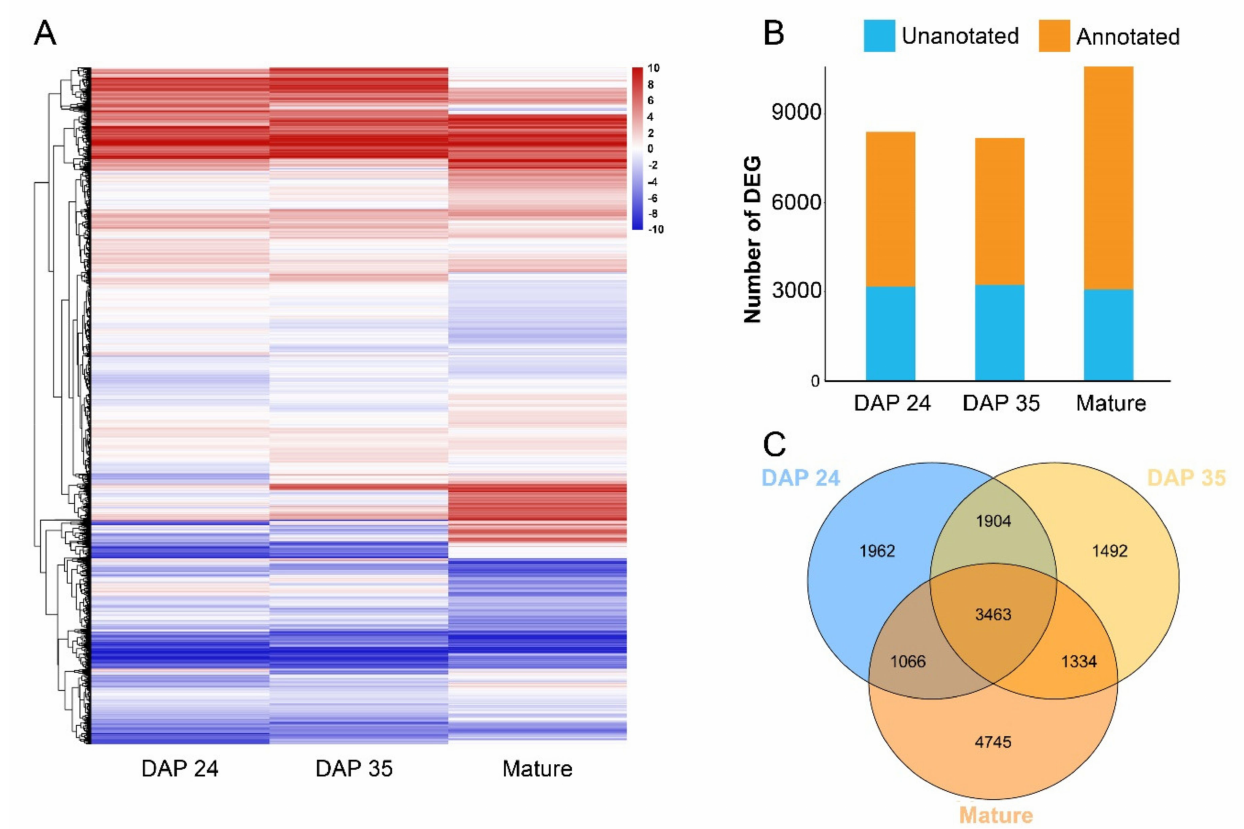
Figure 6. Screening of DEGs in the inbred-specific variation; ( A ) Heatmap of DEGs in comparison between line DAN3130 and JI63 on DAP 24, DAP 35, and mature kernels; ( B ) Number of DEGs in comparison between line DAN3130 and JI63 on DAP 24, DAP 35, and mature kernels; ( C ) Venn diagram of unique and common DEGs in the comparison between line DAN3130 and JI63 on DAP 24, DAP 35, and mature